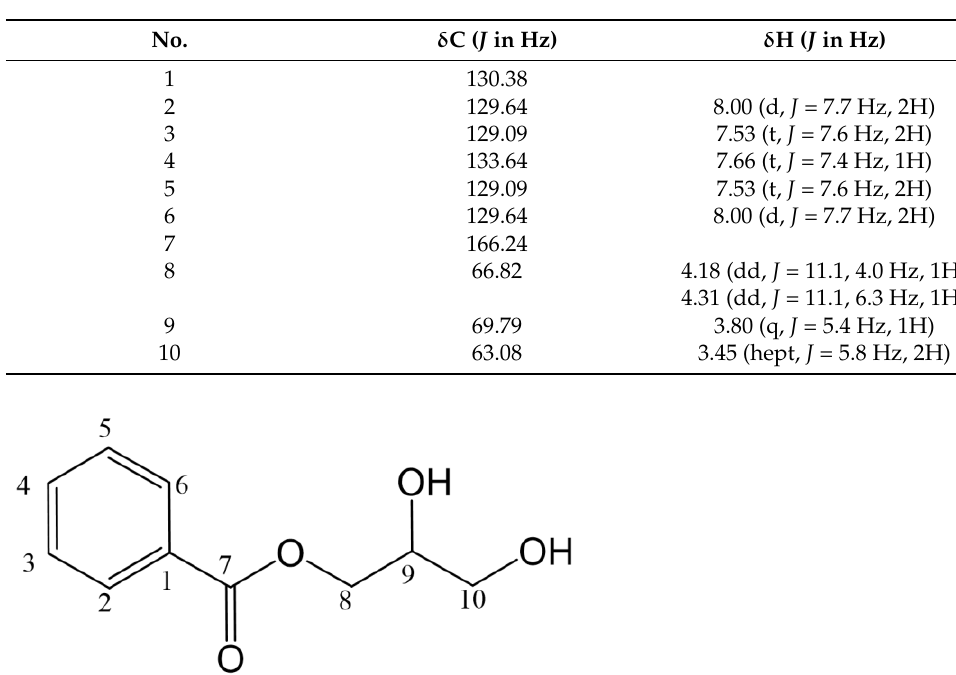
Table 4. 13 C NMR and 1 H NMR data for P3.